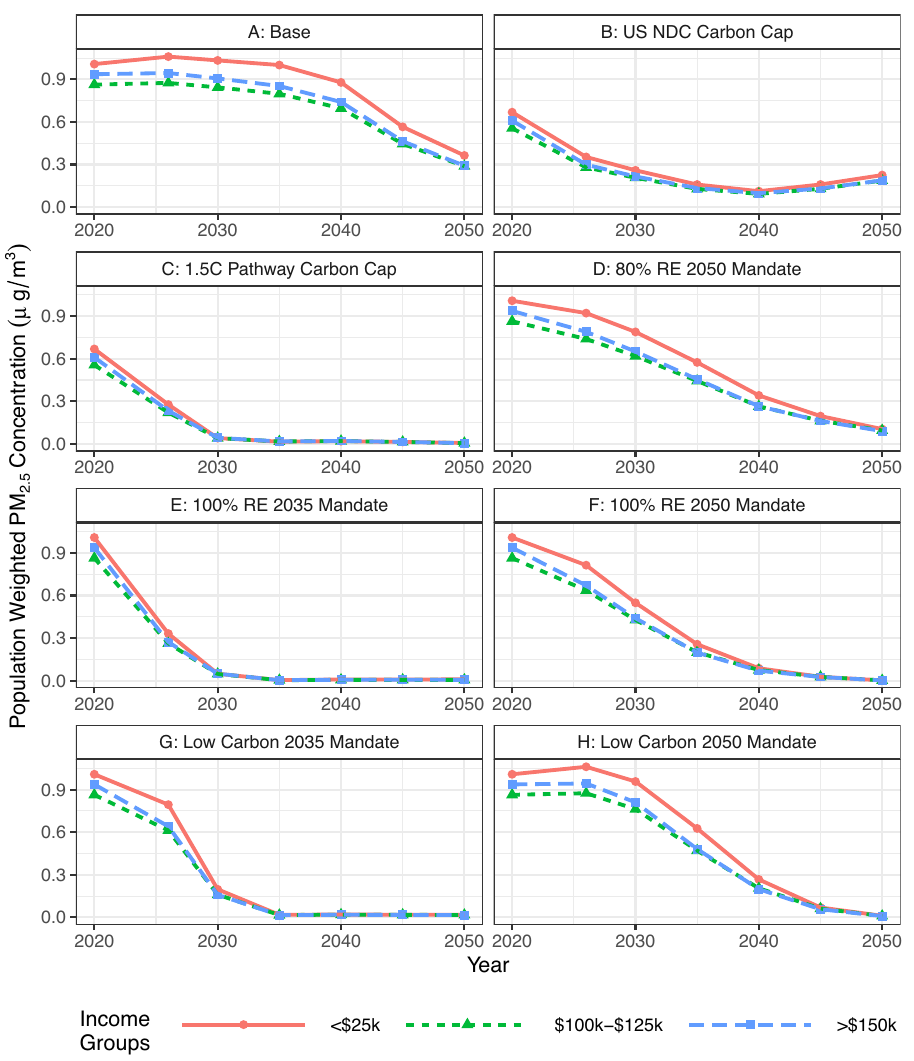
Fig.6|PopulationweightedannualaveragePM 2.5 acrosseachscenario2020to 2050 for the highest (>$150k), mid ($100k-$125k), and lowest (<$25k) income groups in µ g/m 3 . The other income groups fall in between the highest and lowest